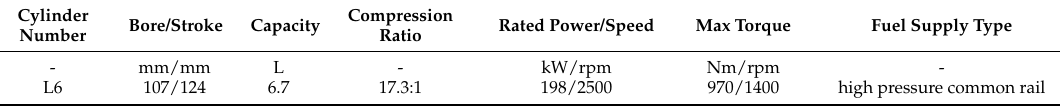
Table 2. Parameters of ISDe270 40 diesel engine.